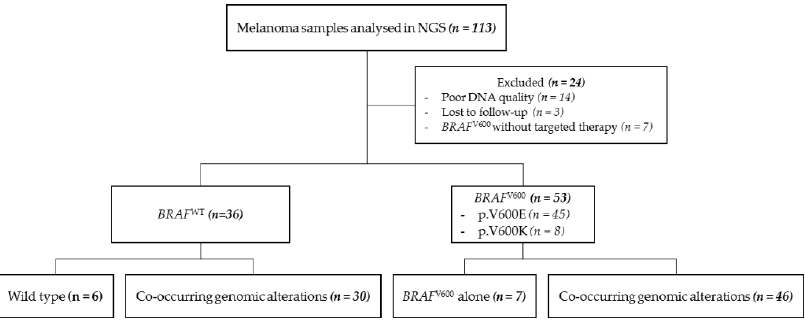
Figure 1. Analytical flowchart of the study. BRAF WT : BRAF wild type, NGS: next generation sequencing. Figure1. Analyticalflowchartofthestudy. BRAF WT : BRAF wildtype,